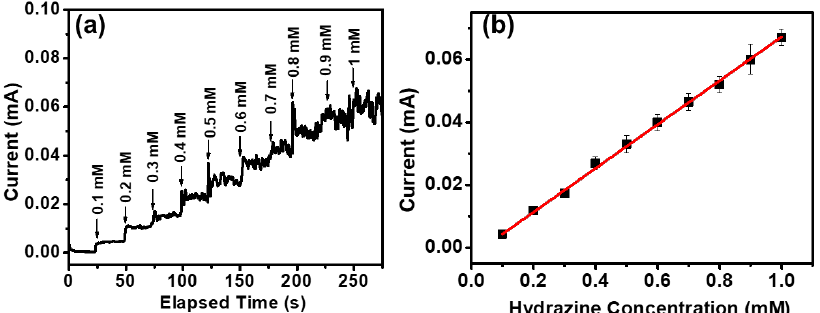
Figure 4. ( a ) Amperometric response of the MoS 2 -QD modified GCE towards sequential addition of hydrazine at 0.61 V vs. Ag/AgCl in 0.1 M PBS solution; ( b ) calibration curve representing the response of MoS 2 -QD modified GCE with different concentrations of hydrazine in a three-electrode system. Table 1. Comparison of the performances of MoS 2 -QD-based hydrazine sensors with other re- ported electrochemical hydrazine sensors.